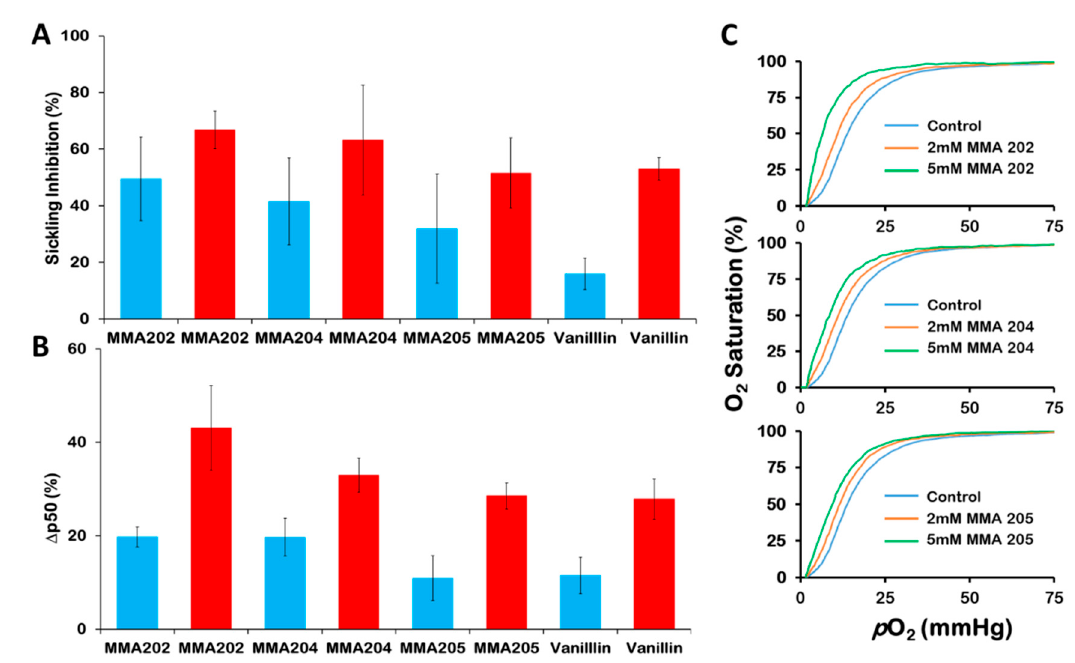
Figure 4. Concentration-dependent SS cells (20% hematocrit) sickling and oxygen equilibrium (P 50 ) shift in vitro by MMA-200 series of compounds. Cyan and red bars denote compound concentrations of 2 mM and 5 mM, respectively. ( A ) Sickling inhibition of SS cells under hypoxia for 2 h, reported as mean values from three replicates, and calculated by normalizing to untreated control samples as previously reported [28]. ( B ) Degree of shift in P 50 . % Δ P 50 values were calculated by normalizing to untreated control samples as shown in Table 1. Hemolysates from the antisickling assay were used for the oxygen equilibrium study. ( C ) Representative oxygen equilibrium curves of lysates from the MMA-202, MMA-204, and MMA-205 antisickling study.